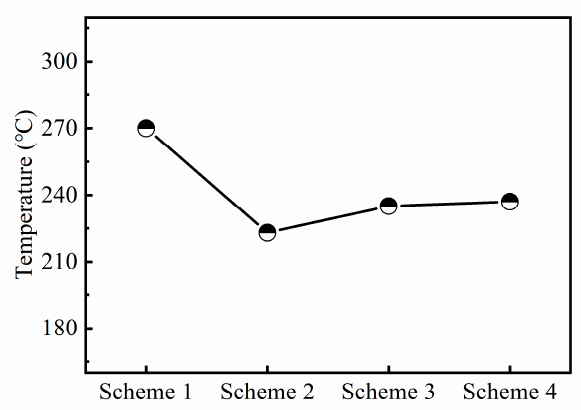
Figure 12. Hotspot temperatures at the meniscus.